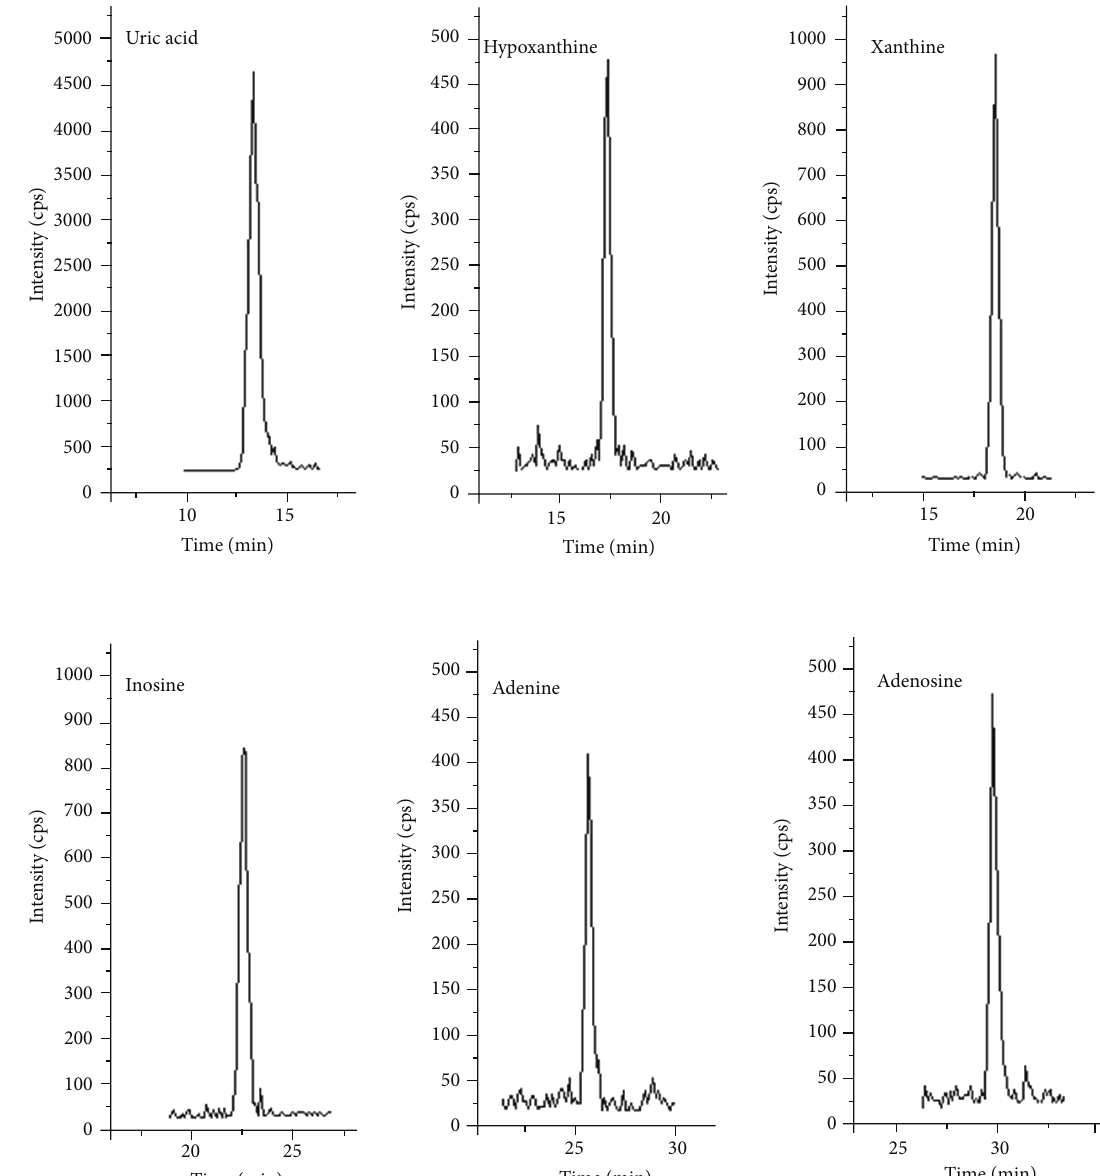
Figure 2: Multiple extracted ion chromatograms of six metabolites in a real plasma sample.